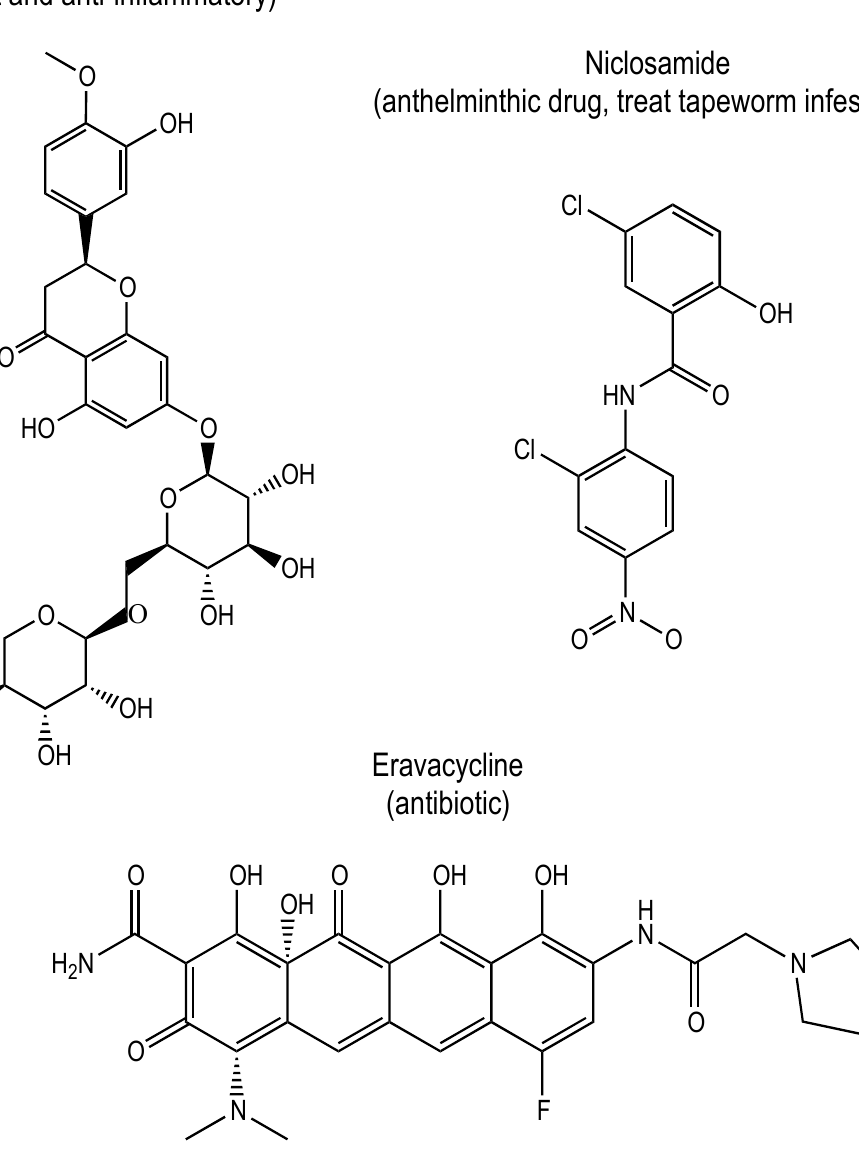
Figure 1. Schematic representation of the studied molecules. The electron donor–acceptor map (DAM) [38] was previously reported as a powerful tool for investigating antioxidant capacity via the electron transfer mechanism. The DAM is shown in Figure 2, together with the values of all the molecules being studied. In DAM, the good electron donor zone is down to the left and the good electron acceptor section is up to the right. All molecules can be classified according to DAM as either electron donors or electron acceptors. In this investigation, molecules with ω + values above 0.5 are con- sidered to be electron acceptors, and those with ω− values less than 4.5 are considered to acceptors rather than electron donors. As mentioned previously [40–43], electron donor and electron acceptor capacity are both important factors in the prevention of oxidative stress. Free radicals are very reactive molecules that present an unpaired electron and produce oxidative stress. Alternatively, electron acceptor molecules are free radical scav- engers, which can accept an unpaired electron, thus deactivating the free radical. Ac- ceptance and donation of electrons are both mechanisms that help scavenge free radicals;